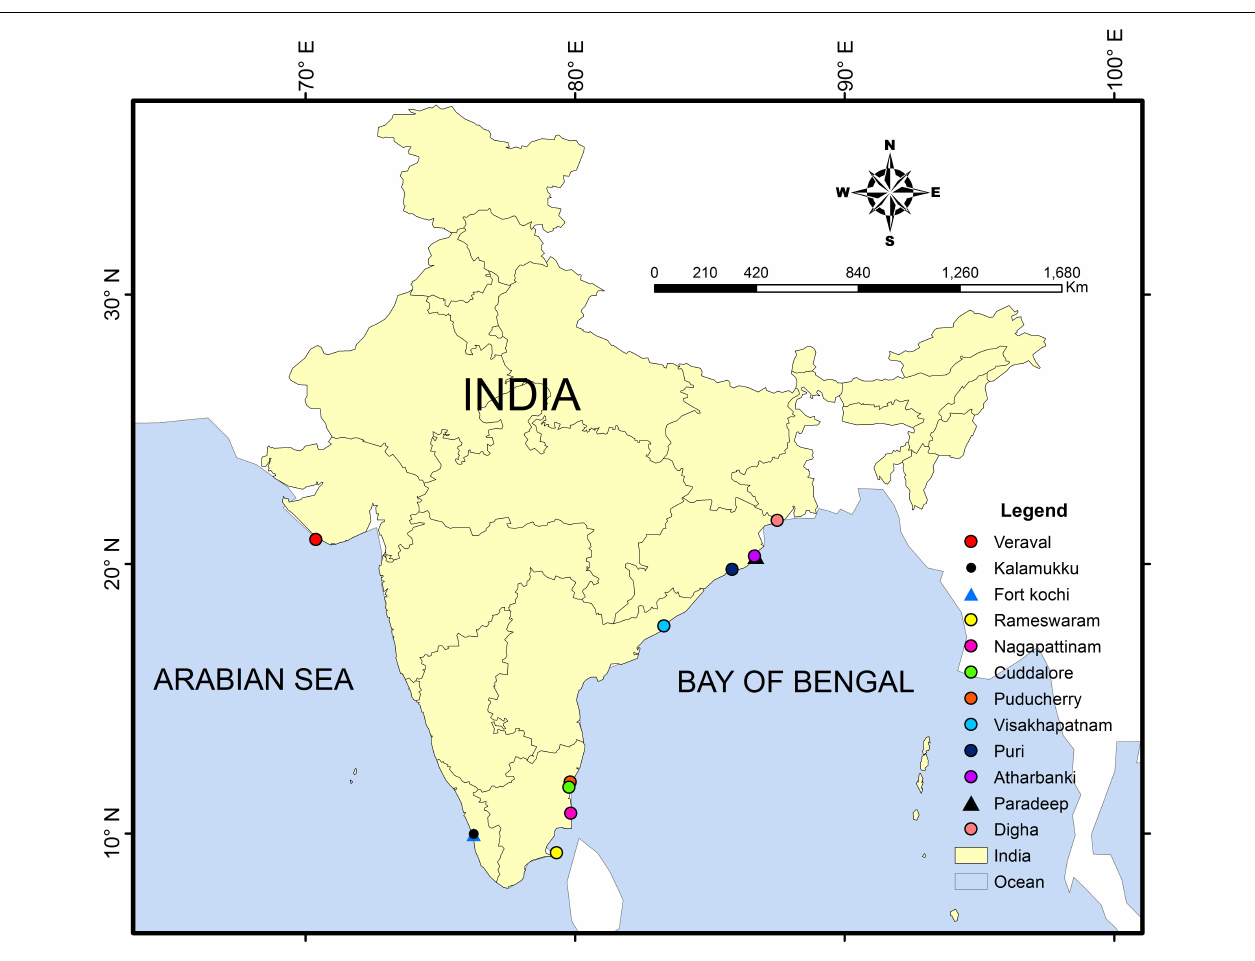
FIGURE 1 | Map showing the sampling locations of Pampus species along the Indian